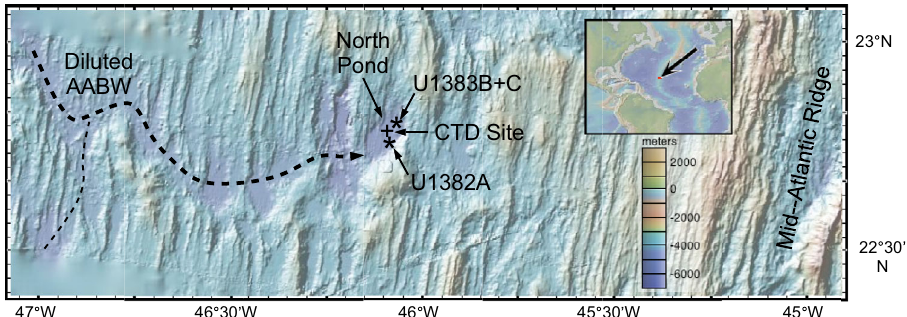
Fig. 1 Location of North Pond in the North Atlantic Ocean and positions of CORKs and CTD casts. Asterisks denote locations of the CORKs; + denotes the position of the two 2014 CTD casts. At the scale of the fi gure, Holes U1383B and U1383C occupy essentially the same position, labeled U1383B + C. Dashed line denotes pathway for cold dense deep waters inferred to be diluted AABW to reach North Pond from deeper water to the west, passing over the deepest sill on southwest side of North Pond. Base map made with GeoMapApp (www.geomapapp.org) 56